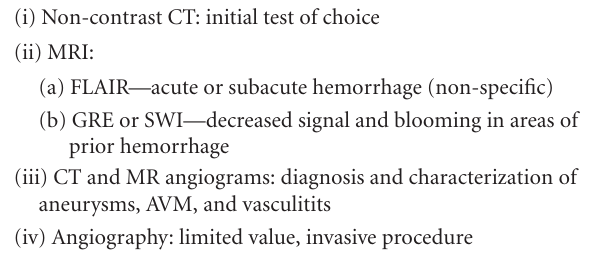
Table 3: Imaging modalities for evaluation of peripheral intracra- nial